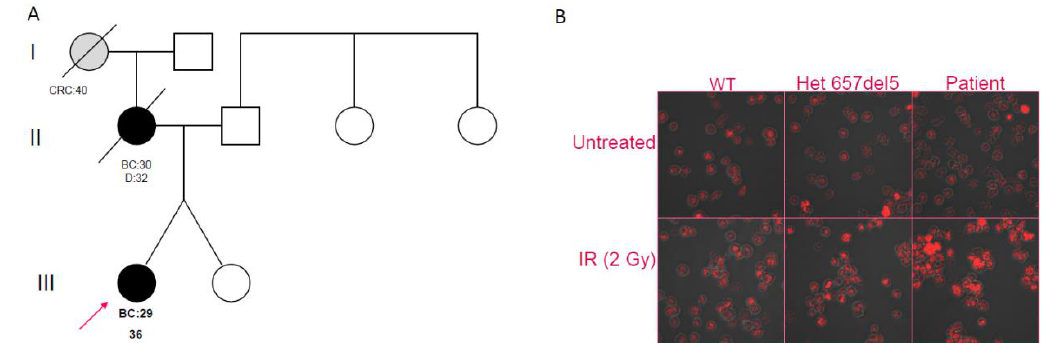
Figure 1. ( A ) Pedigree of Patient 1, showing early-onset breast cancer in the proband and her mother and early-onset colorectal cancer in the maternal grandmother (BC = Breast Cancer; CRC = Colorectal Cancer). ( B ) Confocal analysis on B-LCLs. Untreated cells of a wild-type individual (WT), a c.657del5 heterozygote, and Patient 1 are shown in the upper panes; in the lower panes, respective cells are shown after irradiation treatment (IR).